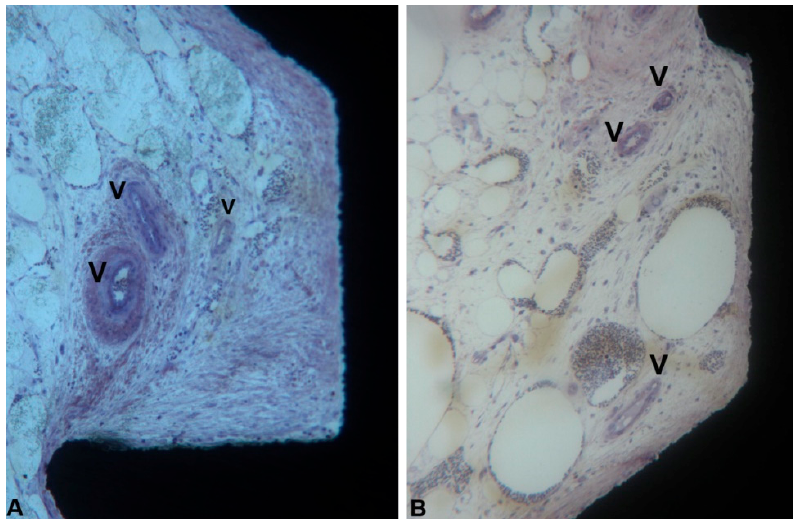
Figure 10. Marrow portion. Many blood vessels (V) were present near the implant surface in the concavities, both in group 1 ( A ) and group 2 ( B ). (Acid fuchsin-Toluidine blue 100X).